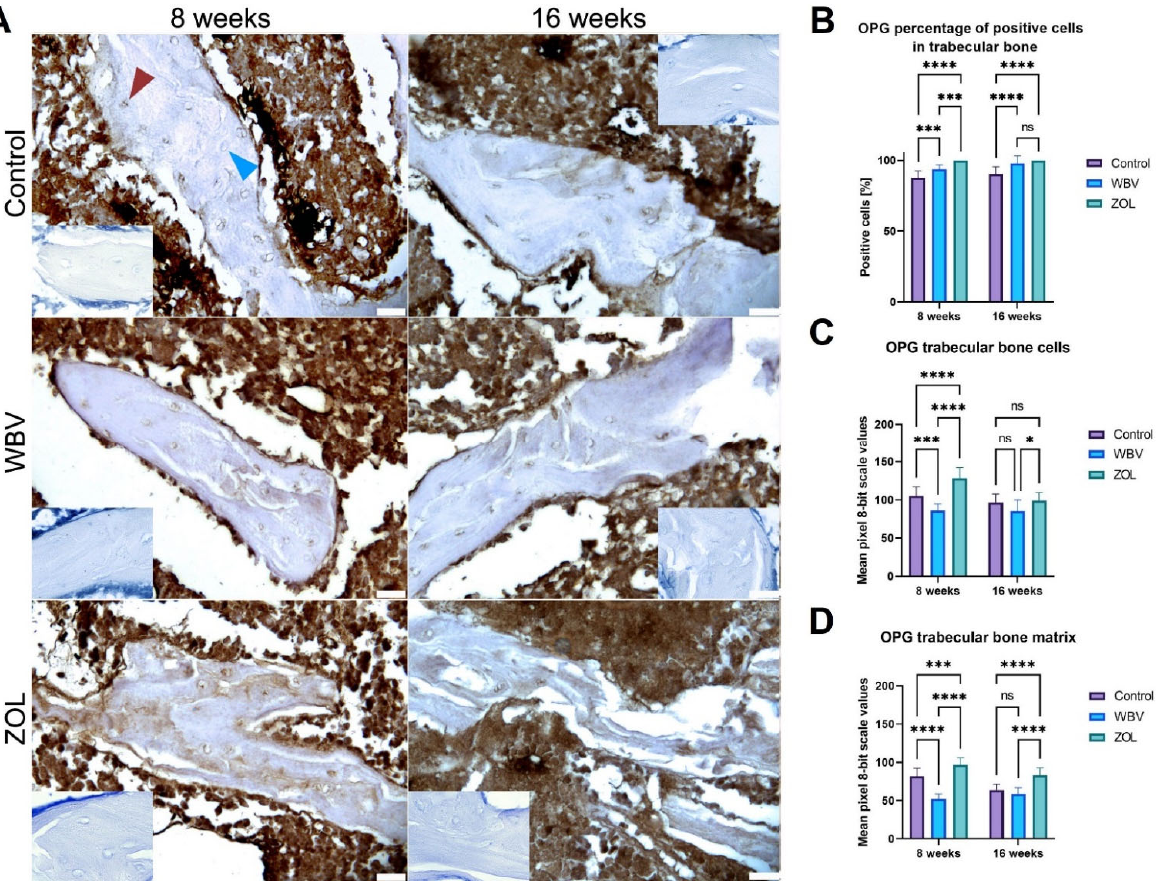
Figure 7. The immunohistochemical reaction for osteoprotegerin (OPG) in the trabeculae of distal metaphysis of femora of rats subjected to obesity and immobility: ( A ) Representative images of the immunohistochemical reactions for OPG. Brown and blue arrowheads indicate examples of positive and negative reaction cells, respectively. Insets show control immunohistochemical staining without primary antibody. All scale bars represent 50 μ m; bar graphs show the ( B ) the percentage of OPG ‐ positive cells and the intensity of immunoexpression of OPG ( C ) in trabecular bone cells, and ( D ) trabecular bone matrix measured by the 8 ‐ bit grayscale pixel brightness value (the higher the pixel value, the higher the intensity of the immunohistochemical reaction). Data are mean values ± SD from n = 6 rats. Control—the control group included rats subjected to obesity and immobility not treated with WBV or ZOL; WBV—the WBV group included rats subjected to obesity and immobility with whole ‐ body vibration treatment (30 min, 5 days per week); ZOL—the ZOL group included rats subjected to obesity and immobility and injected intramuscularly with zoledronic acid at a dose of 0.025 mg/kg body weight every 4 weeks. Statistical significance: ns—not significant; * p < 0.05; *** p < 0.001; **** p < 0.0001 (Tukey’s HSD test or Kruskal–Wallis H test).